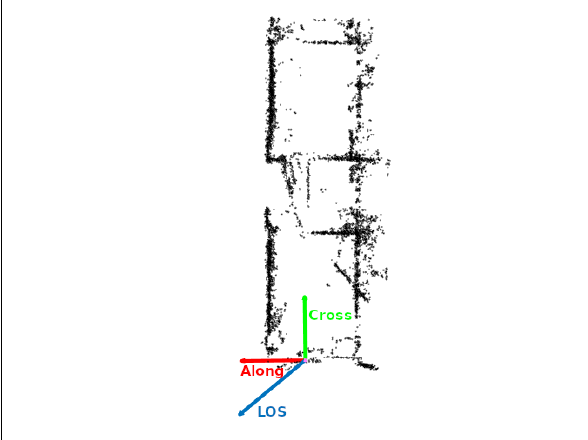
Figure 10. Top view on the PS point cloud and the orientation of the local reference frame used by the 3D tachymeter. LOS indicates the direction of the satellite’s line-of-sight. The corresponding measurements are shown in Figure 11.